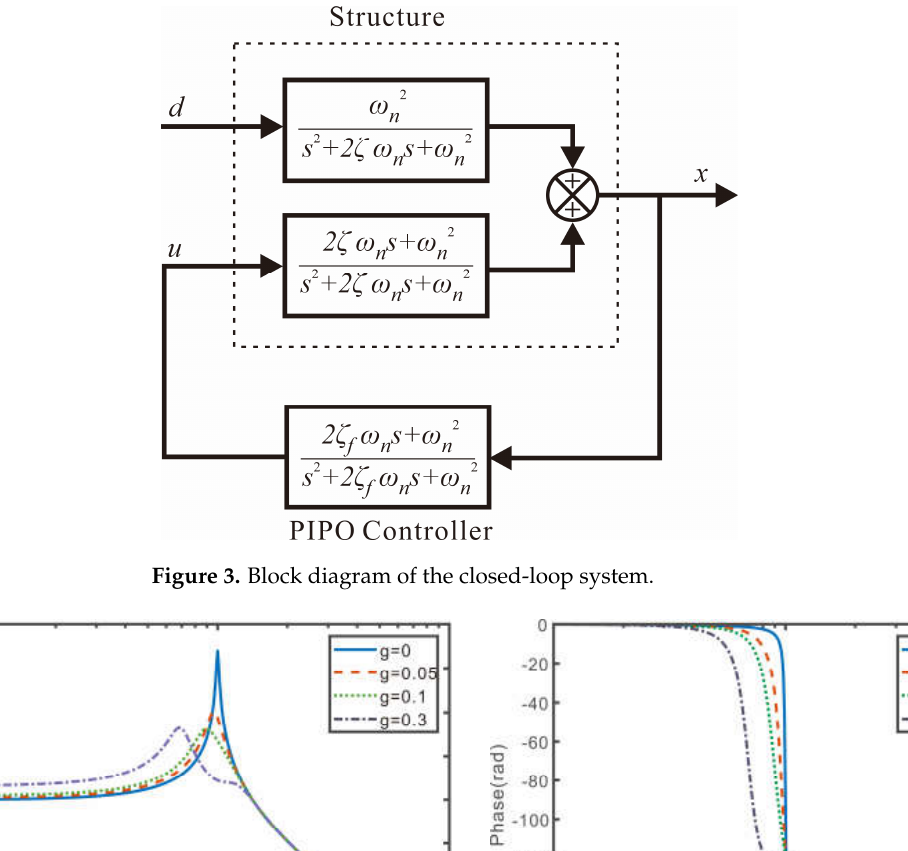
Figure 3. Block diagram of the closed-loop system.